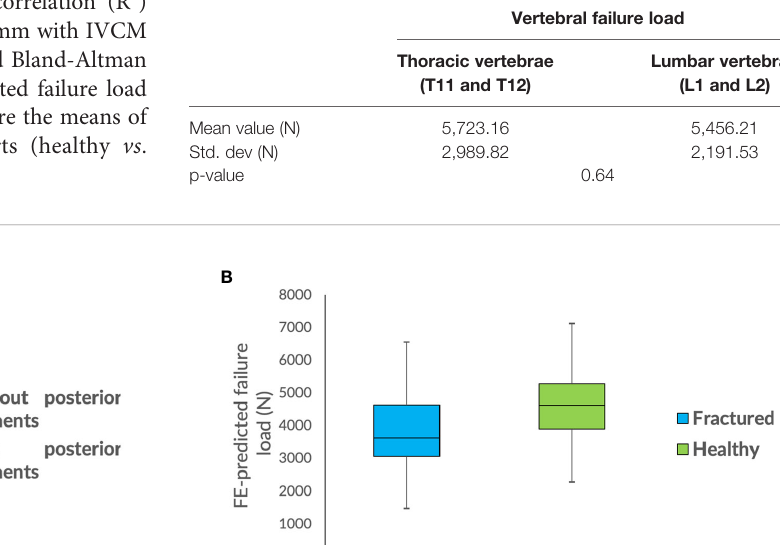
TABLE 2 | Finite element (FE)-predicted vertebral failure load values (mean and std. dev) and level of signi fi cance for thoracic and lumbar